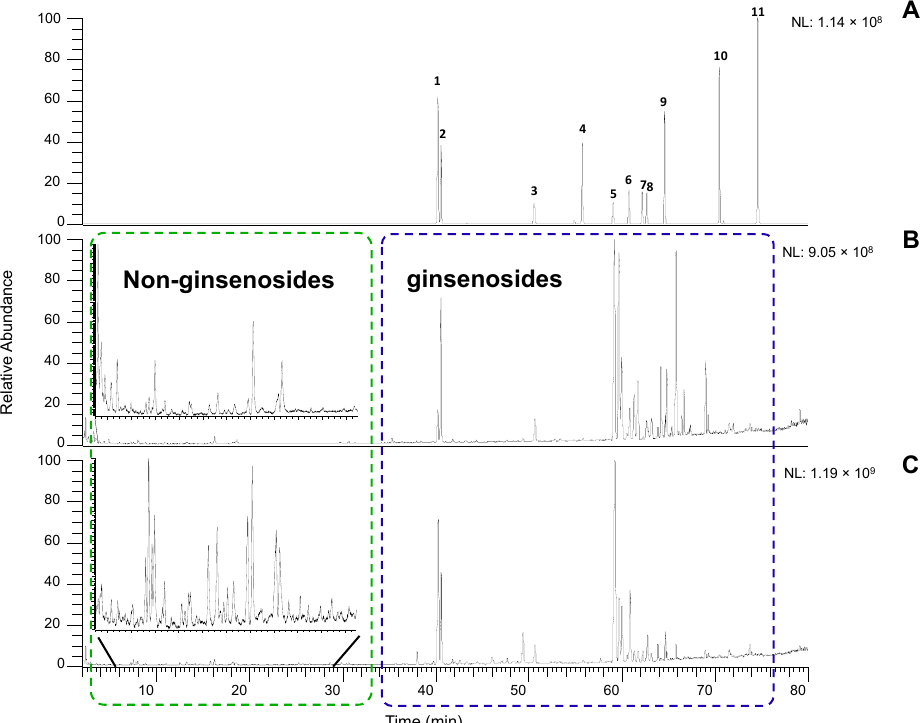
Figure 1. Extracted ion chromatograms of ginsenoside standard ( A ), and total ion chromatograms of wild ( B ) and cultivated ( C ) in negative ion mode (ESI − ). The peak number labels in Figure 1A refer to the ginsenosides in Table S1. The extraction range of Figure 1A was selected as ± 0.05 Da of theoretical m/z shown in Table S1.